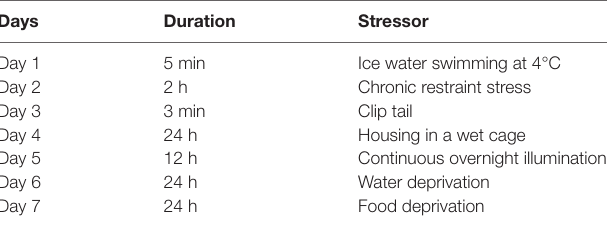
TaBle 1 | The chronic unpredicted mild stress procedure of applied stressors during 1